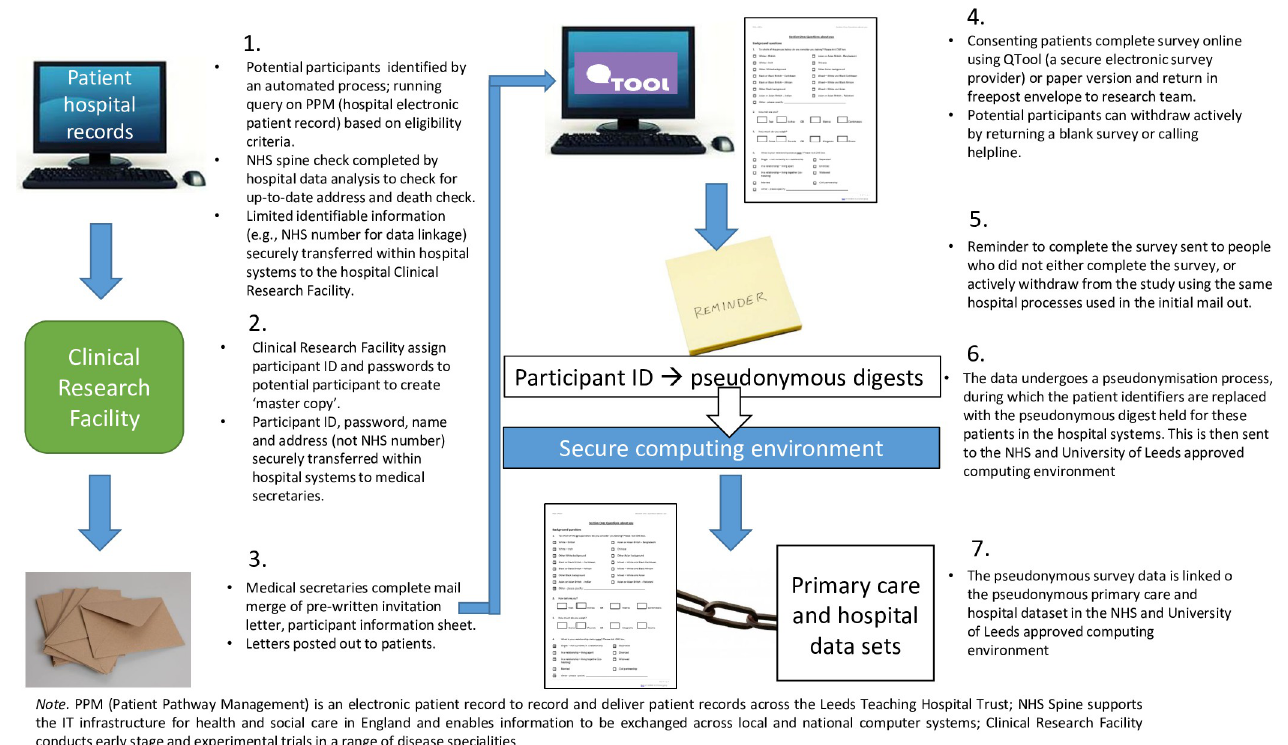
Fig 1. Diagram illustrating a brief over view of CPR PROMs data collection and pseudonymisation. Note . PPM (Patient Pathway Management) is an electronic patient record to record and deliver patient records across the Leeds Teaching Hospital Trust NHS Spine supports the IT infrastructure for health and social care in England and enables information to be exchanged across local and national computer systems Clinical Research Facility conducts early stage and experimental trials in a range of disease specialities.